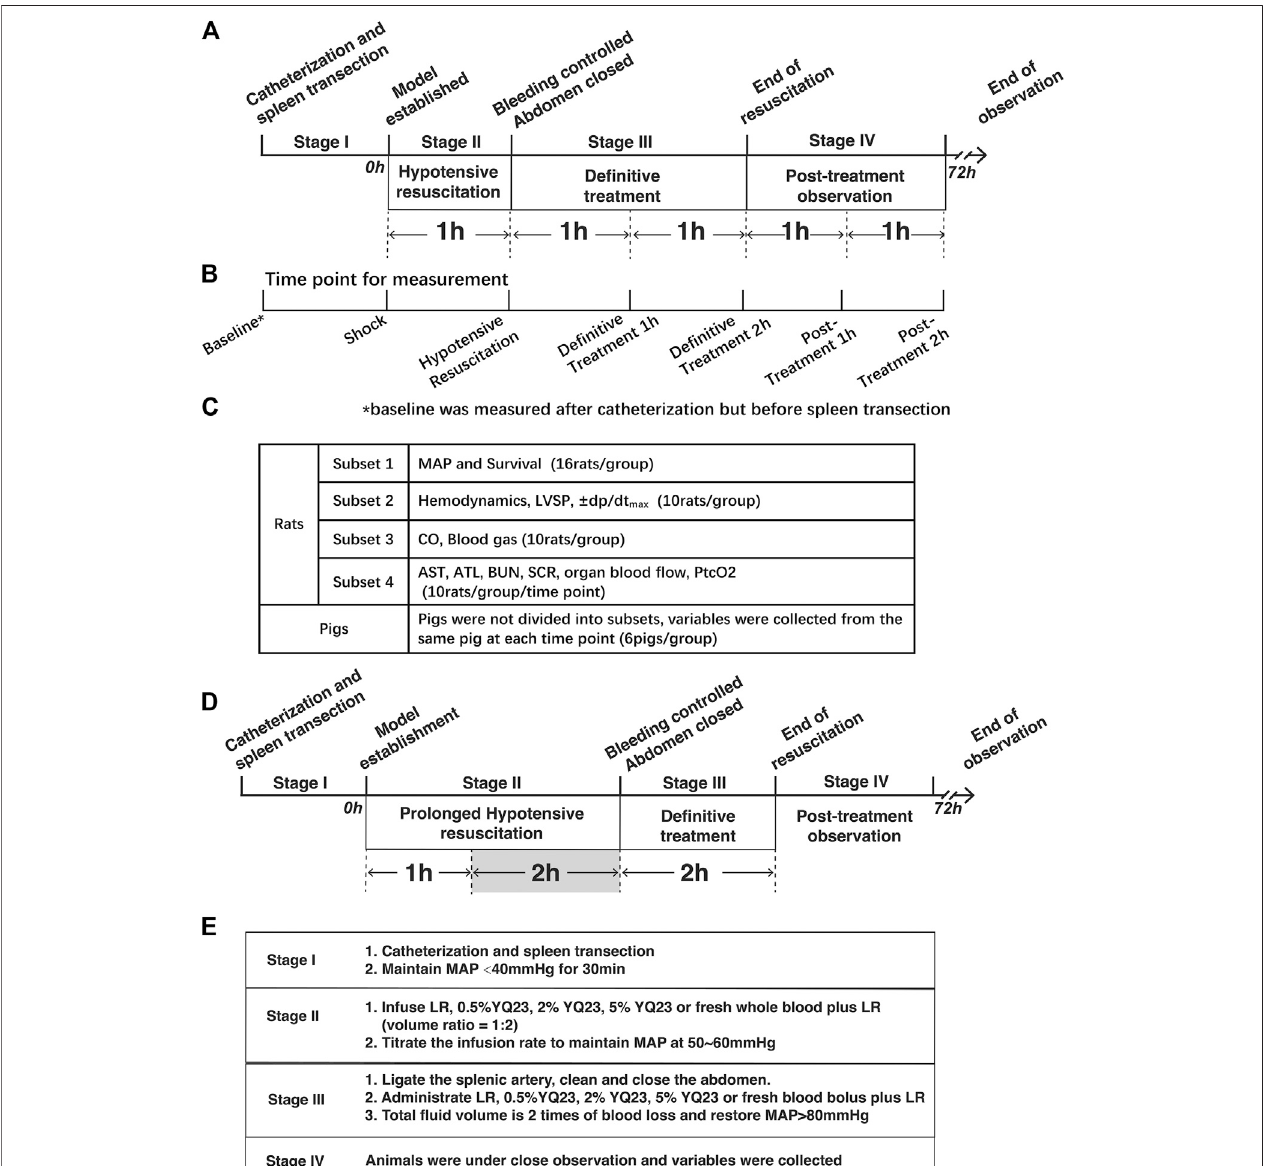
FIGURE1|Schematicsofthestudydesign.(A) ,StagedTreatmentinExperimentPart1,ratsandpigsundergostagedtreatment.InStageI,pigsandratswere catheterizedandthespleentransectionwasperformedtoreplicatetheuncontrolledhemorrhagicshockmodel.InStageII,thehypotensiveresuscitationwascarriedout for 60 min, duringwhich YQ23,LR, and wholeblood plus LRwereinfusedtorestoreMAPto50 – 60 mmHg. InStage III,bleeding wascontrolledand de fi nitivetreatment wascarriedout,theabove fl uidswerefurtherinfusedforthenext120 minandthetotal fl uidvolumeistwotimesofbloodloss.InStageIV,animalswereunderclose observation whentreatmentwasended.Variableswerecollectedduringand aftertreatment.Dataofratswerecollectedform4subsets experiments. (B) ,Timepoint for variablecollection,variables werecollectedatthe7indicatedtime point; (C) ,Designofratexperimentsubsets,ratsweredividedinto4subsetsfortheindicatedvariable collection at each time point; (D) , Staged-treatment of Experiment Part 2, the hypotensive resuscitation duration was extended to 180 min and the de fi nitive treatment alsolastedfor120 mintoobservewhetherYQ23couldgaintimeforsubsequenttreatment. (E) ,stagedtreatmentwork fl ow,abrieflistoftreatmentsinthecorresponding stage was shown. LR, Lactate Ringer ’ s solution; MAP, mean arterial